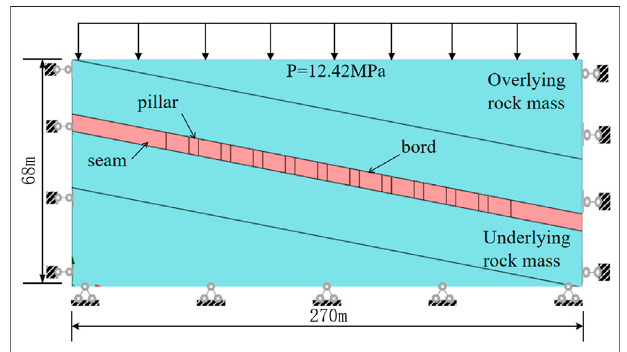
FIGURE 7 | PLAXIS2D modeling diagram.